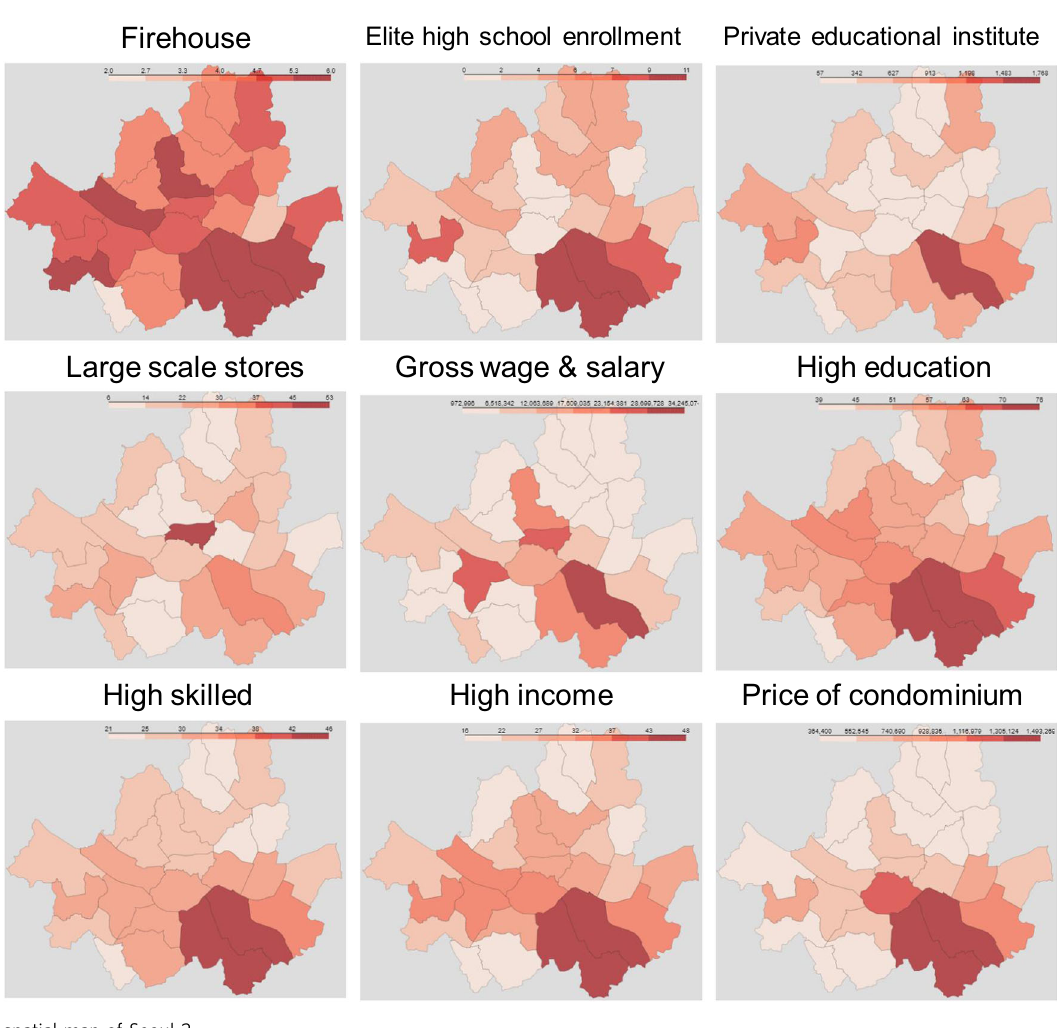
Fig. 4 Socio-spatial map of Seoul